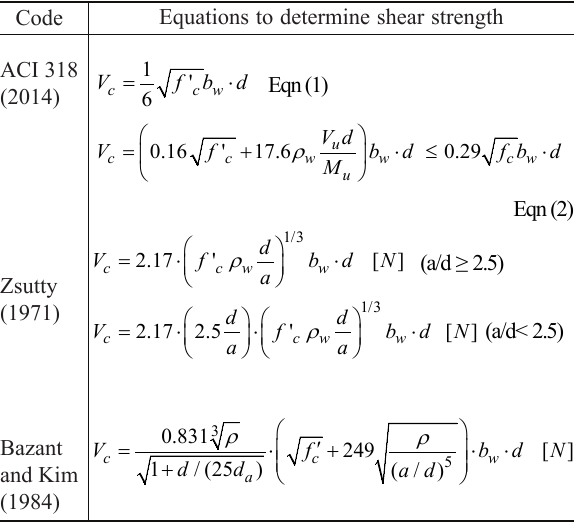
Table 1. Existing equations to determine shear strength of beams with no stirrups Code